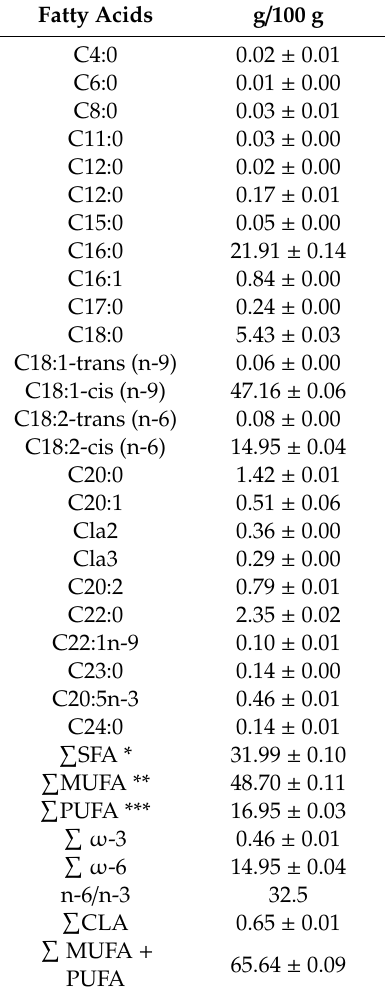
Table 4. Fatty acid profile of teosinte